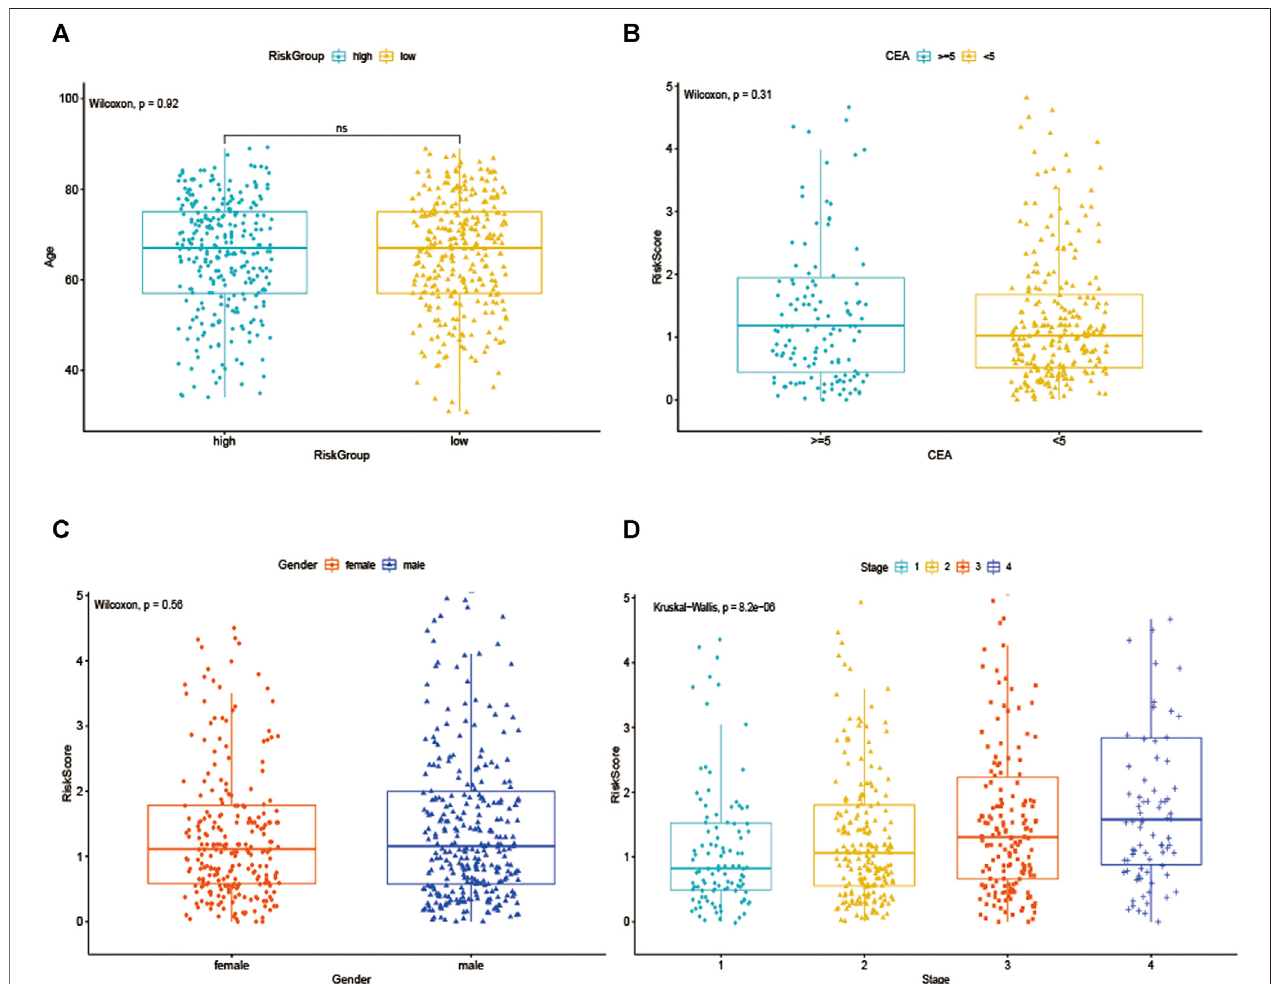
FIGURE 3 | The association between EMT-related signature risk score and clinical factors, including. (A) Age, (B) CEA, (C) Gender, (D) Stage.